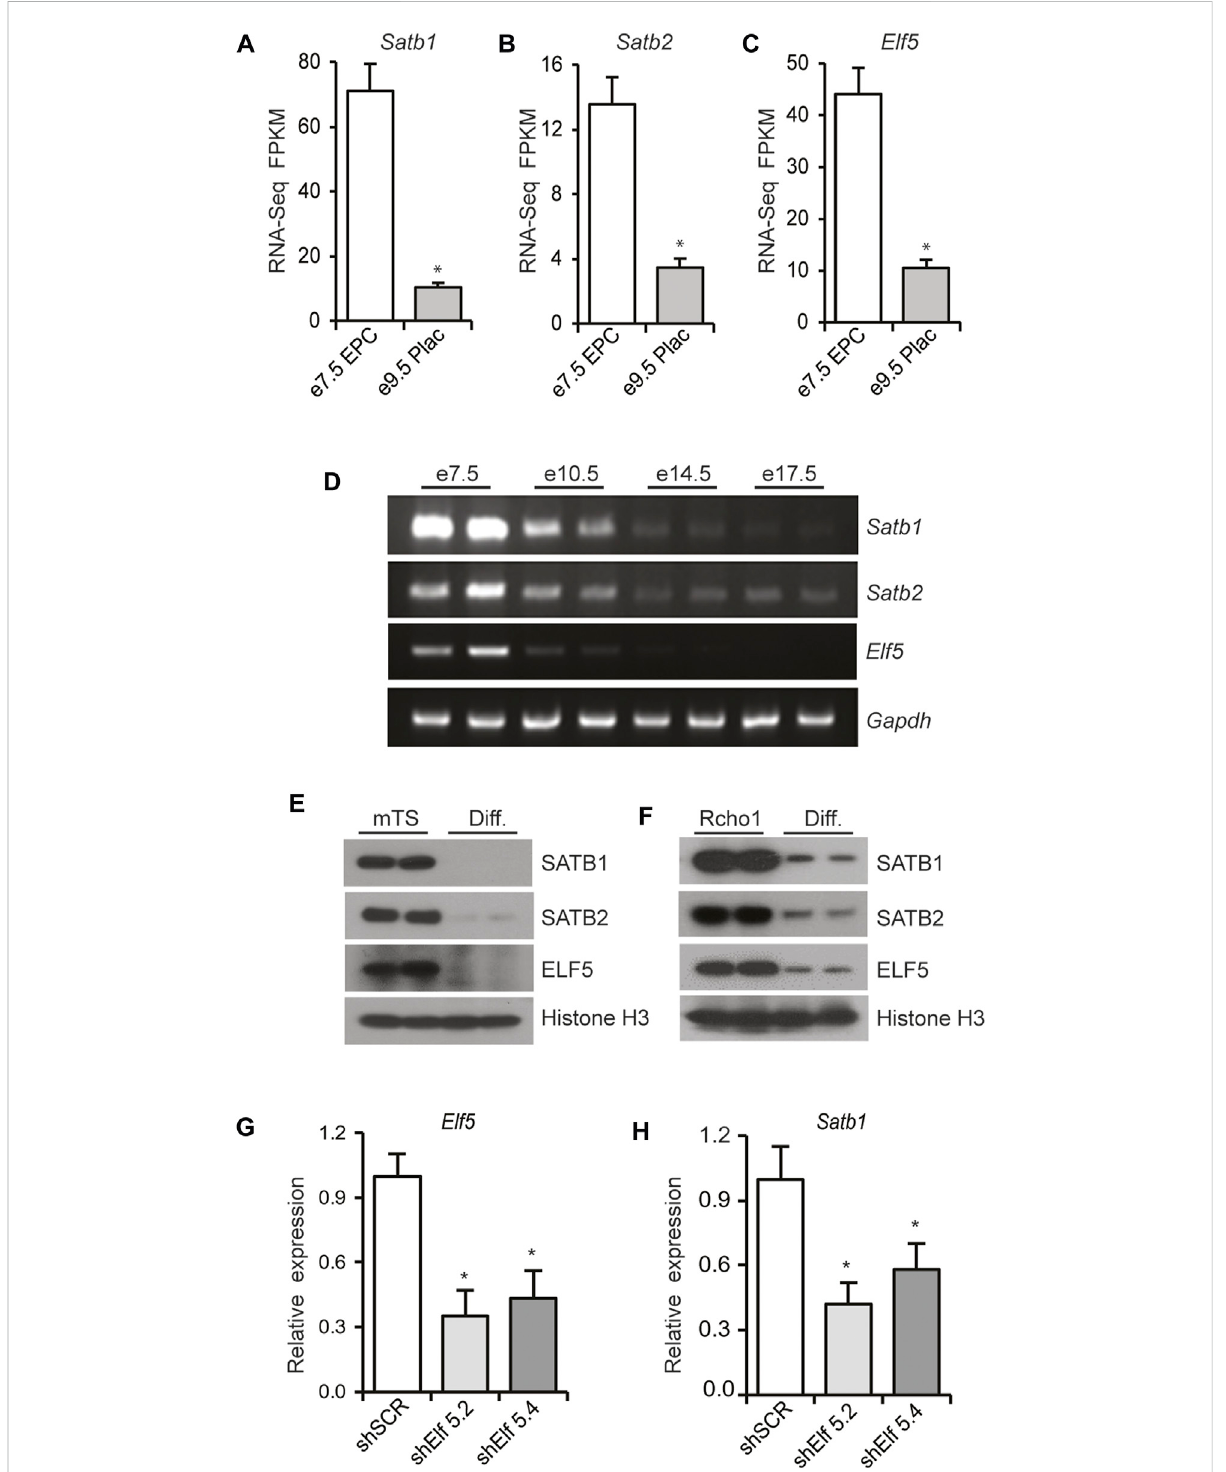
FIGURE 7 ELF5 regulates Satb1 expression in TS cells. (A – C) RNA-seq analysis demonstrated that expression of Satb1 , Satb2 , and Elf5 is dramatically reduced in mouse e9.5 placentas compared to e7.5 EPCs. Similar fi ndings were observed in RT-PCR analyses of mouse placenta samples collected during the progression of gestation (D) . Both mouse TS cells and Rcho1 rat TS cells exhibited similar reductions in SATB1, SATB2 and ELF5 proteins upon induction of differentiation (E,F) . In G, Rcho1 rat TS cells were stably transduced via lentivirus, with either control or Elf5 shRNAs, 5.2 or 5.4 as described in Section 2. ShRNA mediated knockdown of Elf5 (G) signi fi cantly reduced Satb1 mRNA expression (H) , suggesting a role of Elf5 in transcriptional regulation of Satb1 . RNA-Seq FPKM and RT-qPCR data are expressed as the means ± S.D. * p < 0.05 ( n =